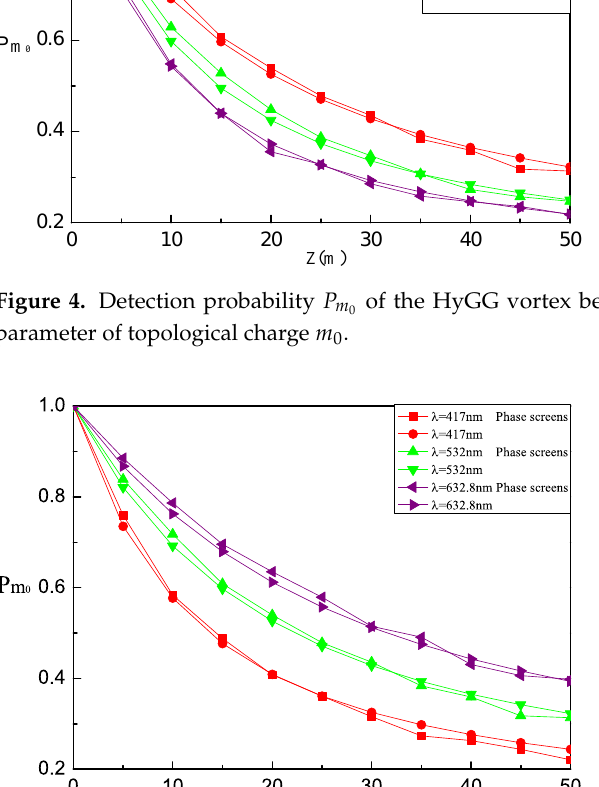
of the HyGG vortex beam against z versus the initial beam 0